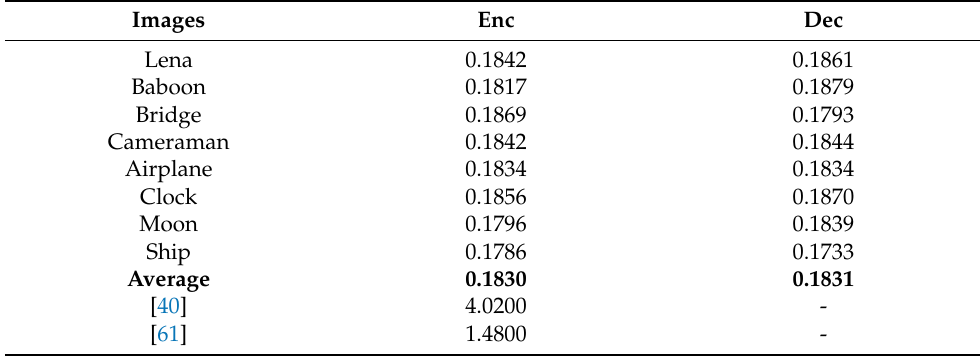
Table 7. Execution time of encryption (Enc) and decryption (Dec) in seconds. Images